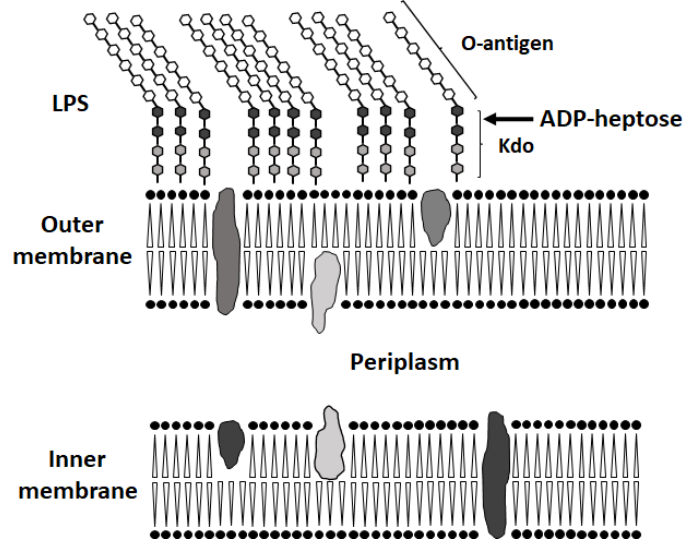
Figure 1. Cell wall structure of gram-negative bacteria. ADP-heptose attaches O-antigen polysaccharide chains to the inner core (Kdo) [4]. The “ deep-rough ” mutant LPS structure is unstable due to the lack of negatively charged phosphate groups on heptose residues, which normally stabilize the structure through the interaction with positive ions. Furthermore, the “ deep-rough ” phenotype leads to increased susceptibility to hydrophobic compounds [5].